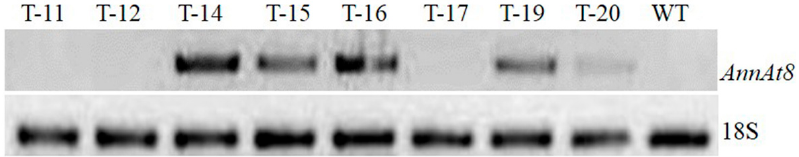
Figure 2. Expression analysis of AnnAt8 in AnnAt8 overexpressing transgenic tobacco plants by semi-quantitative RT-PCR. WT is taken as non-transgenic control. 18S was used as a reference.